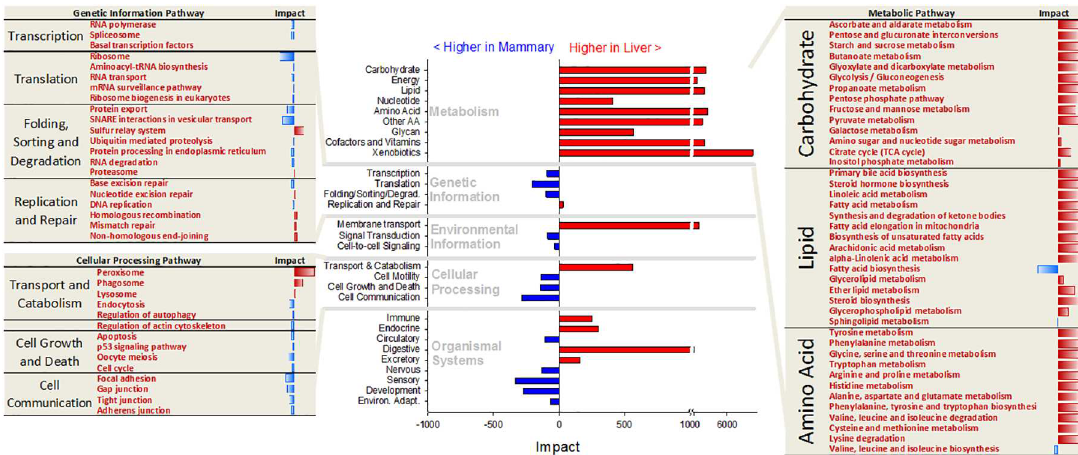
Fig 2. Direction of the impact of main sub-categories of KEGG pathways (in the center, with main categories of pathways reported in light grey font) and most impacted pathways in the ‘Genetic Information processing’, ‘Cellular Processing’, and ‘Metabolism’ subcategories of pathways. For the ‘Metabolism’ subcategories of pathwaysonly the one related to carbohydrate, lipid, and amino acid metabolismare shown(red font = more activated in liver and blue font = more activated in mammary